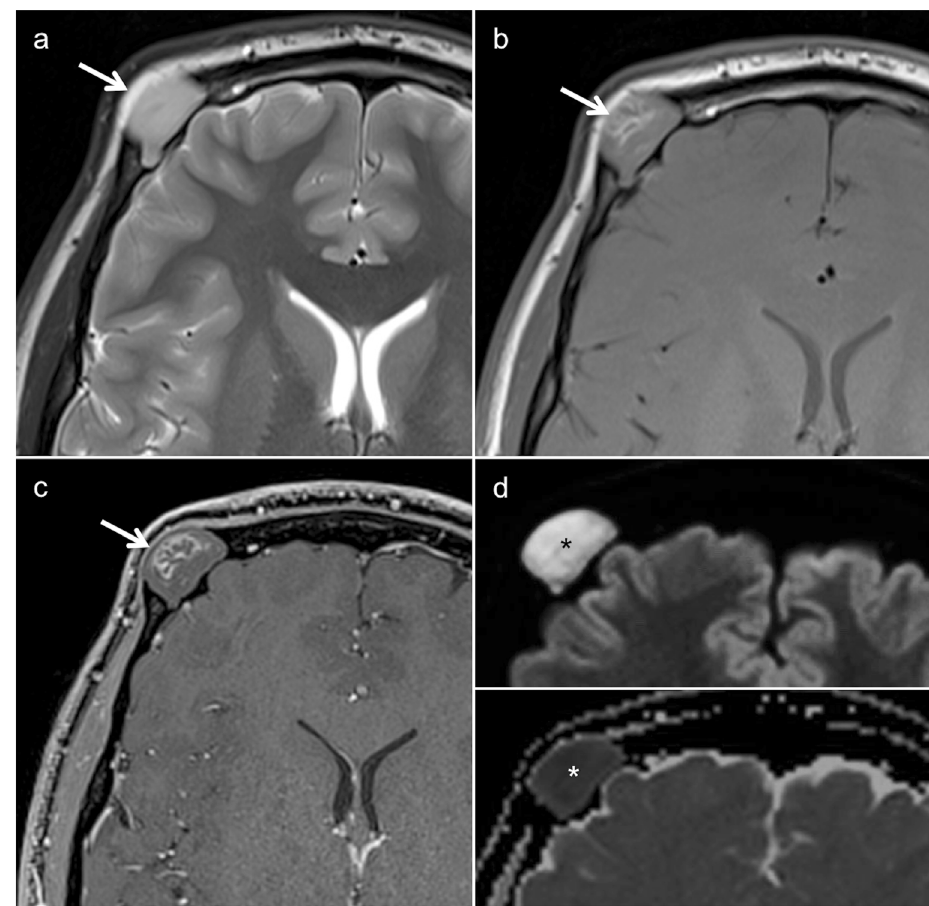
Fig. 7 Intraosseous dermoid cyst (DC) in a 17-year-old male presenting as a gradually enlarging right supraorbital swelling since three years. a Cystic lesion in the right frontal bone ( arrow ) with non- lipomatous contents on axial T2. On T1 ( b ) and fat-saturated contrast-enhanced T1 ( c ), the lesion appears hypointense and displays intracystic serpiginous hyperintense areas which correspond to haemorrhage, high protein content or saponification ( arrows ). d DWI reveals high signal on the b = 1000 image ( asterisk , upper image part ) and low signal on the ADC map ( asterisk , lower image part , ADC = 0.6 × 10 − 3 mm 2 /s), compatible with restricted diffusion and characteristic of